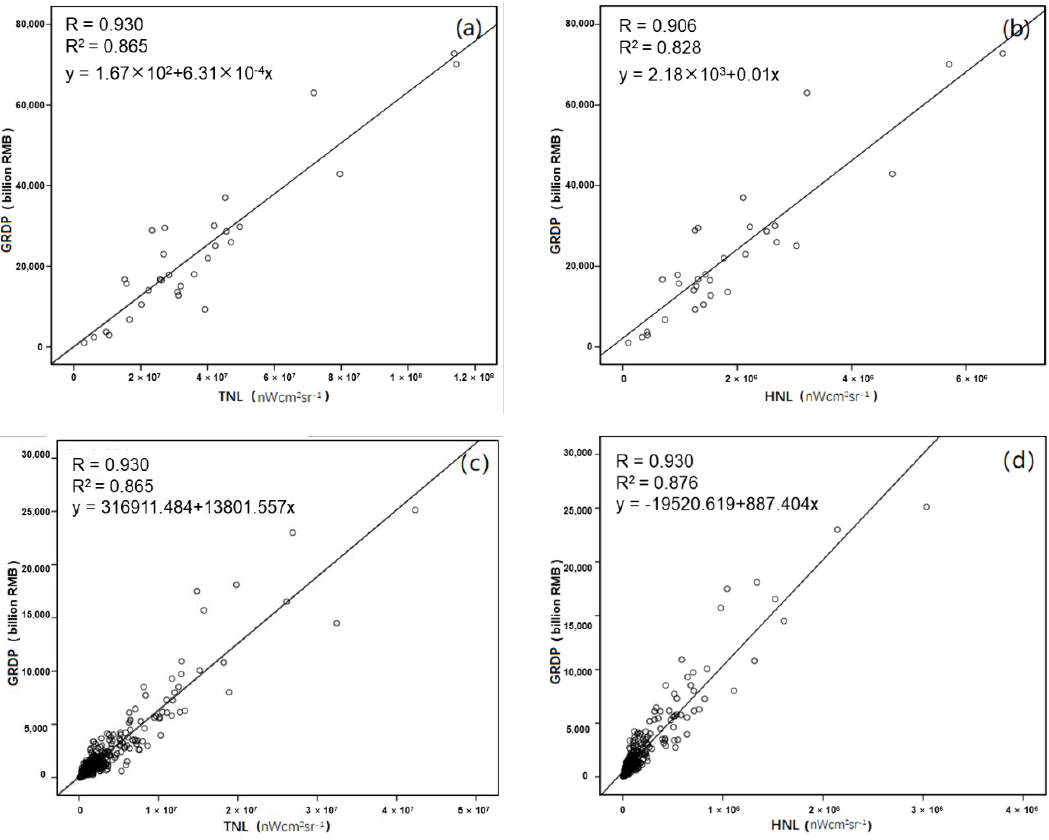
Figure 13. The scatter diagram of linear regression analysis: ( a ) The GRDP and TNL in provincial units, ( b ) The GRDP and HNL in provincial units, ( c ) The GRDP and TNL in prefectural units, ( d ) The GRDP and HNL. in prefectural units.